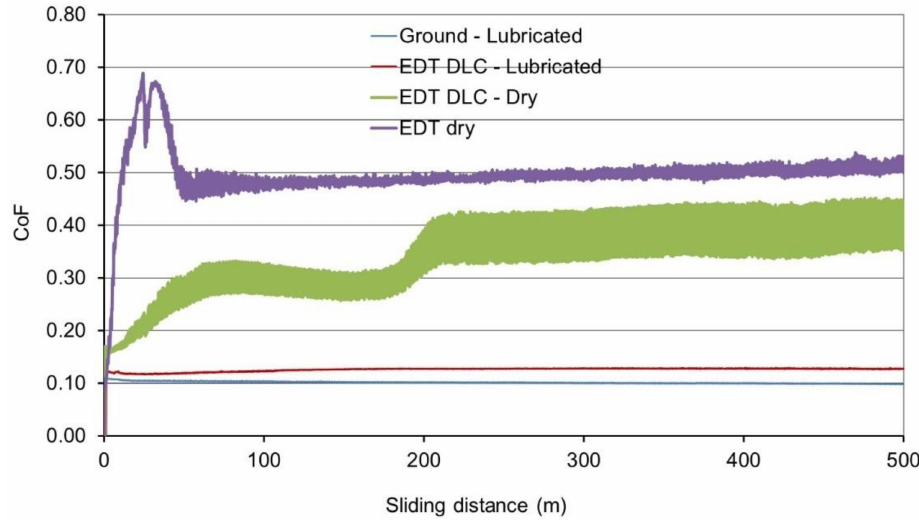
Figure 11. Comparison of the evolution of the coefficient of friction (CoF) with sliding distance.